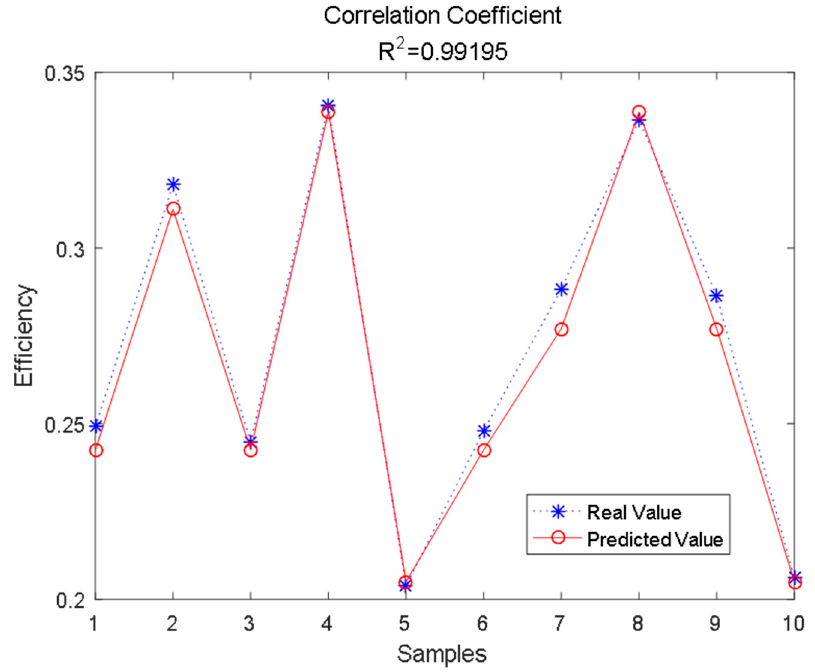
Figure 12. Efficiency predicted value by BP with learning rate optimization ( η = 0.01).